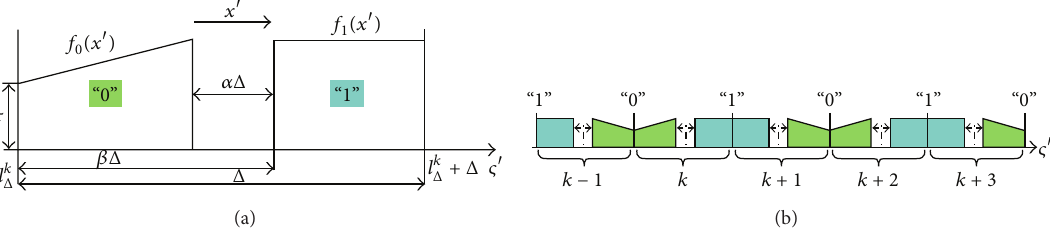
Figure 2: Distribution of the quantized coefficients: (a) inside 𝑘 th embedding interval; (b) in five consecutive